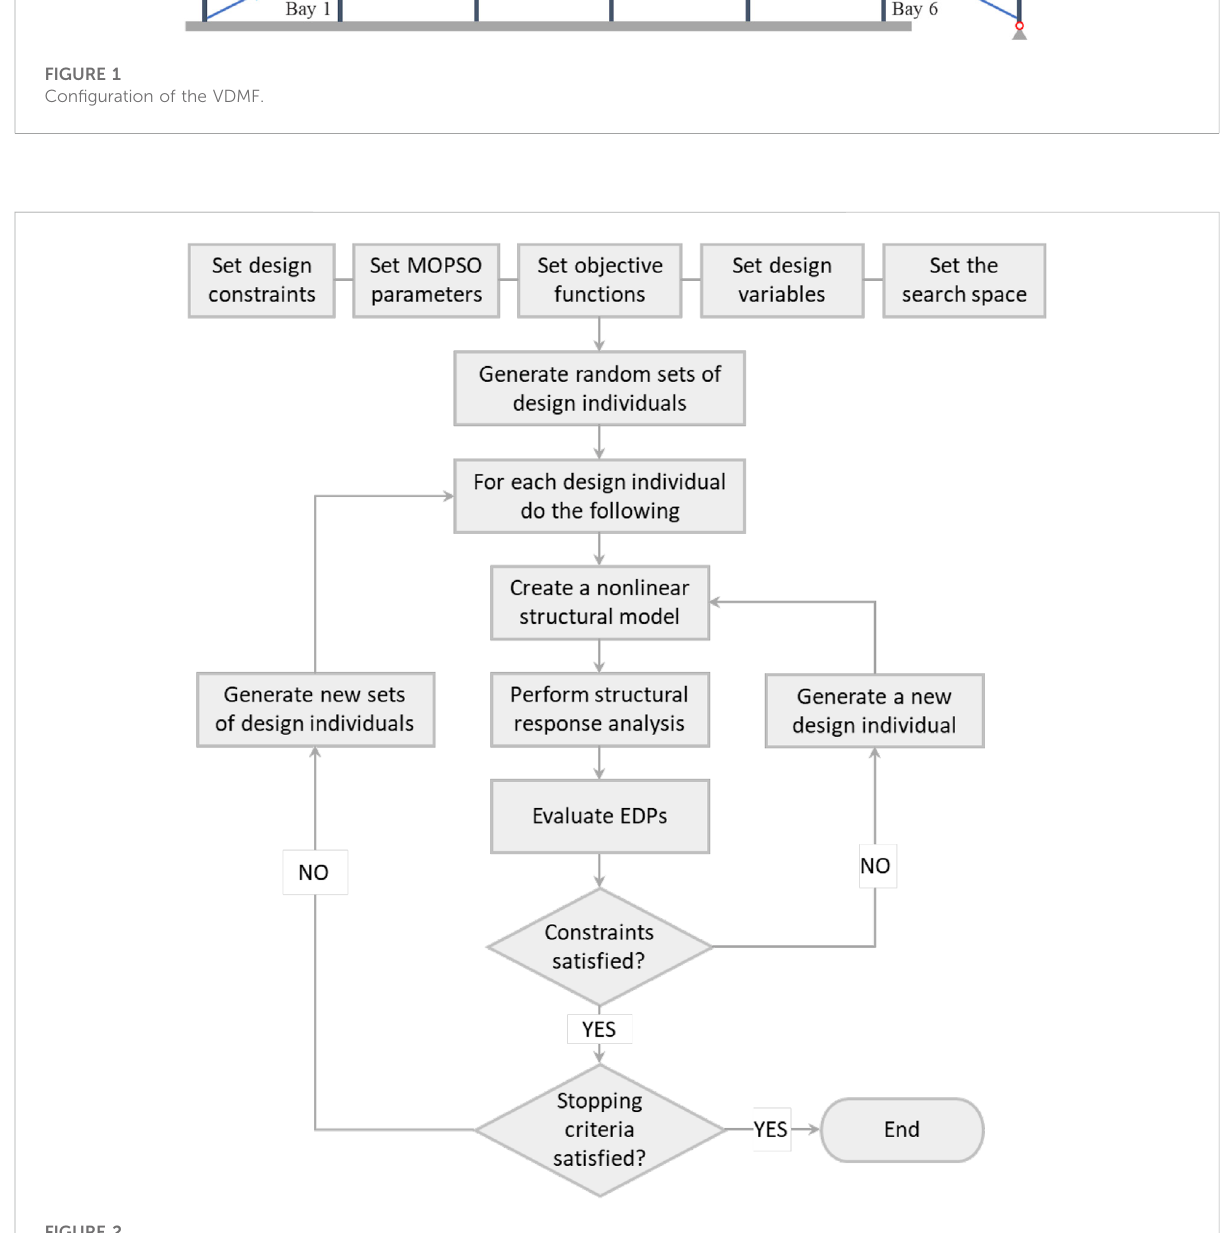
FIGURE 2 Flowchart of the proposed adoption of